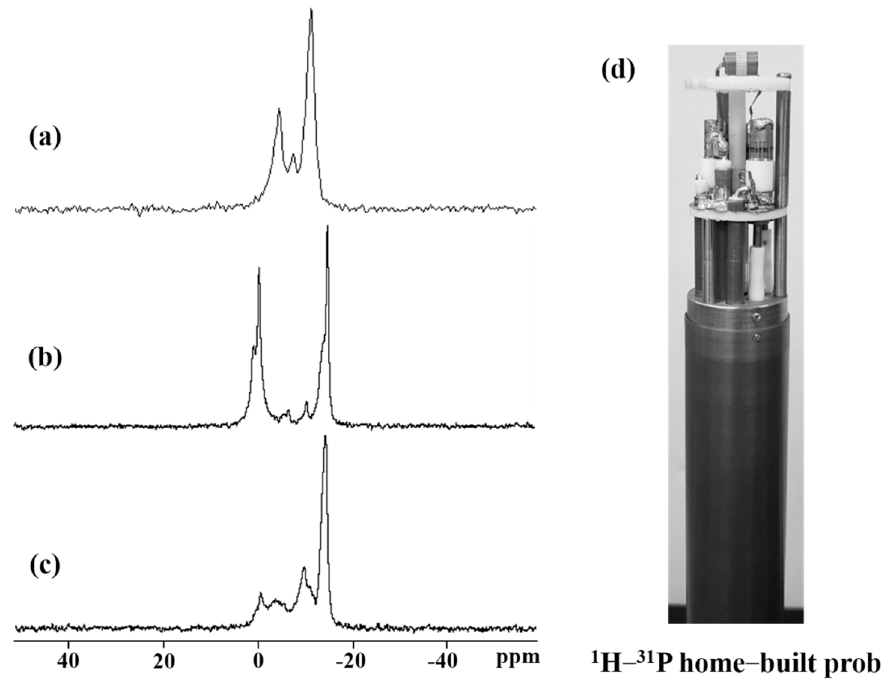
Figure 8. 1D 31 P solid − state NMR spectra of bicelle without YK5 ( a ), following the addition of 0.5 mM YK5 ( b ) and 1.0 mM YK5 ( c ) at 40 °C. ( d ) 1 H − 15 N home-built double-resonance solid-state NMR probe with scroll coil.